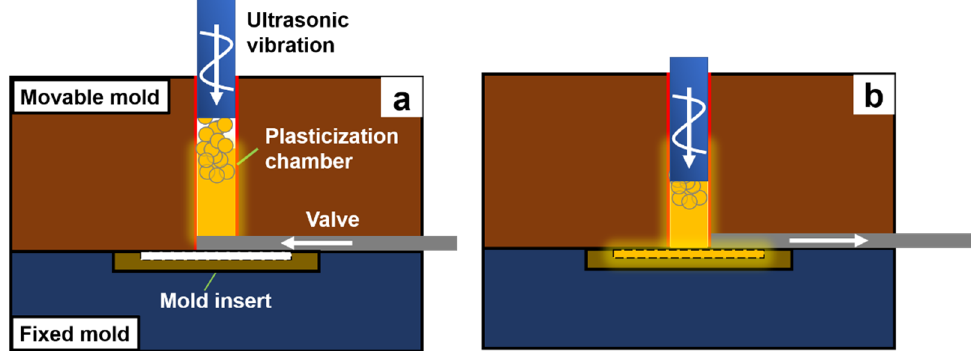
Figure 3. Schematic illustration of two different modes. ( a ) Mode 1, ( b ) Mode 2.